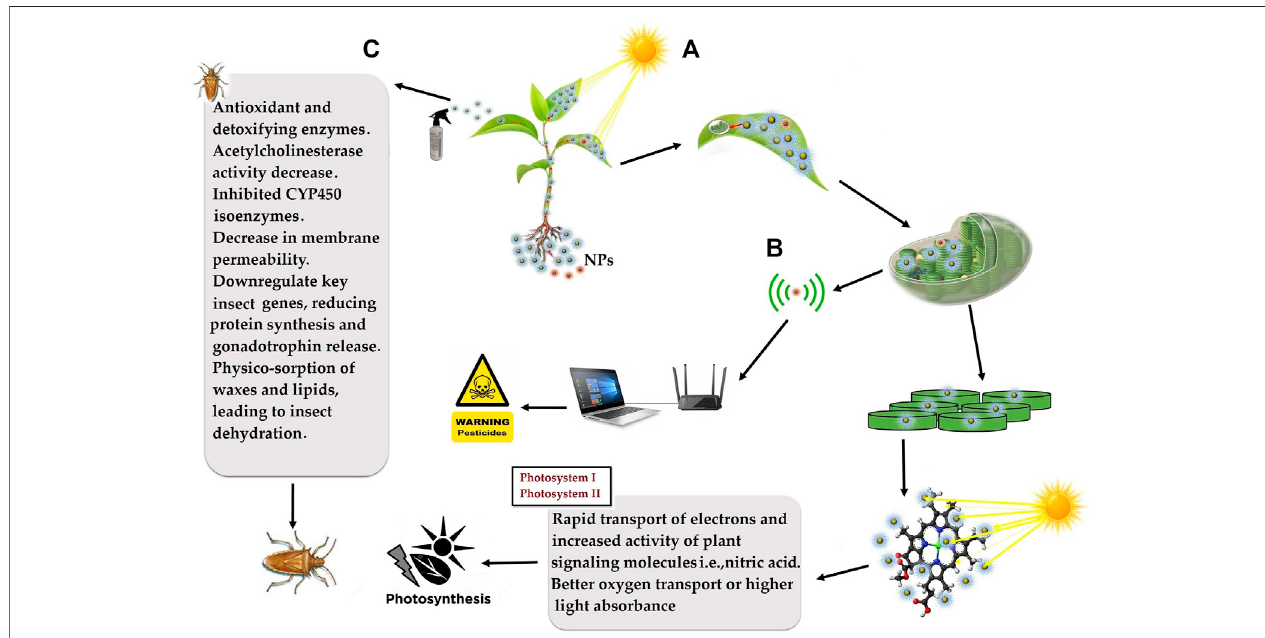
FIGURE 6 | Schematic diagram of nanoparticles application for; (A) enhanced light harvesting to accelerate the rate of photosynthesis for increased biomass accumulation and crop yield, (B) nanobionics application in early detection of pathogenic infection and pesticidal poisonous residues for improved biosafety, and (C) slow-release nanopesticides application for precise and durable pest